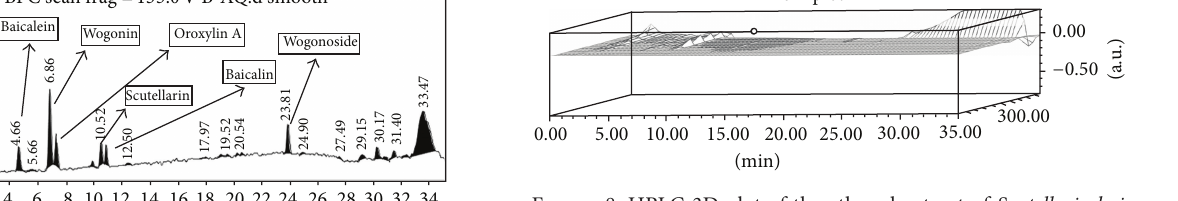
Figure 8: HPLC-3D plot of the ethanol extract of Scutellaria bai-